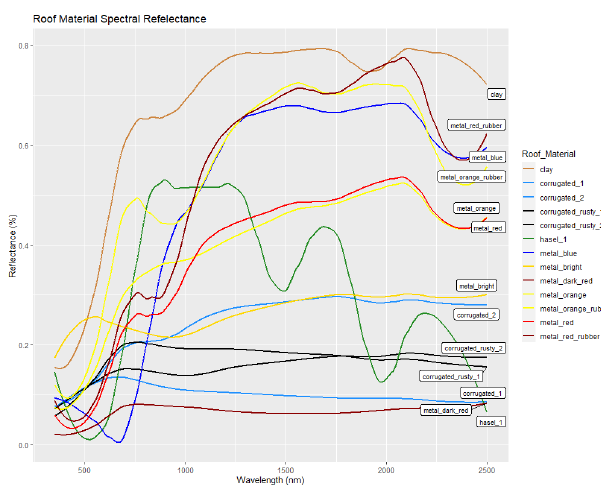
Figure 4: Roof Material Spectral Reflectance in